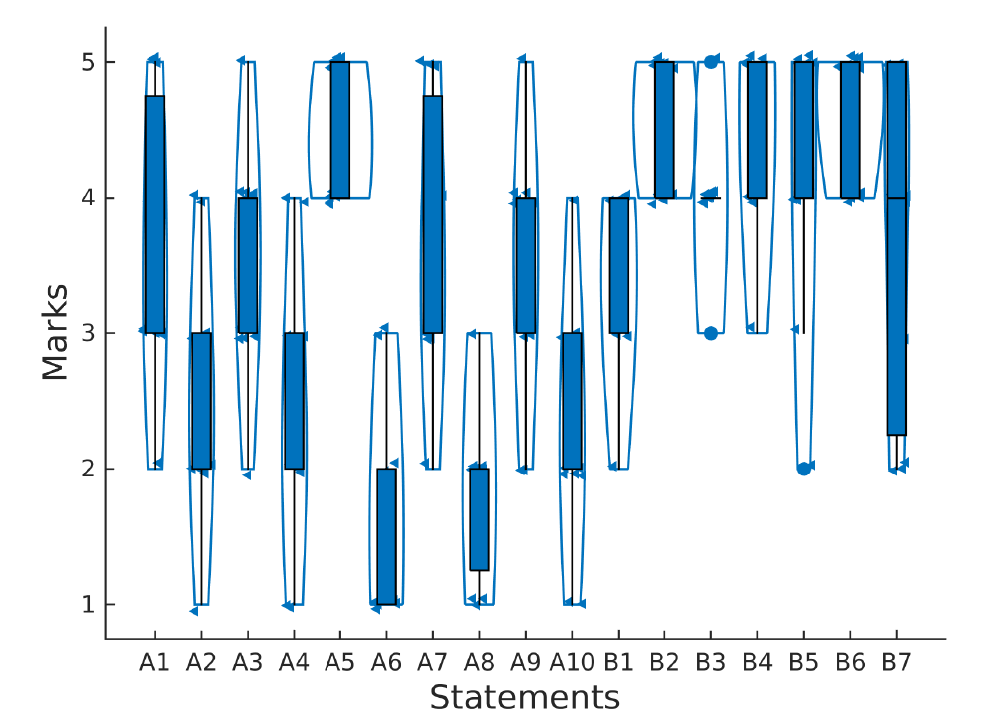
Figure 7. Box and violin plots containing the marks of SUS statements (A1, A2, ..., A10) and specific to the basic signal processing library (B1, B2, ...,